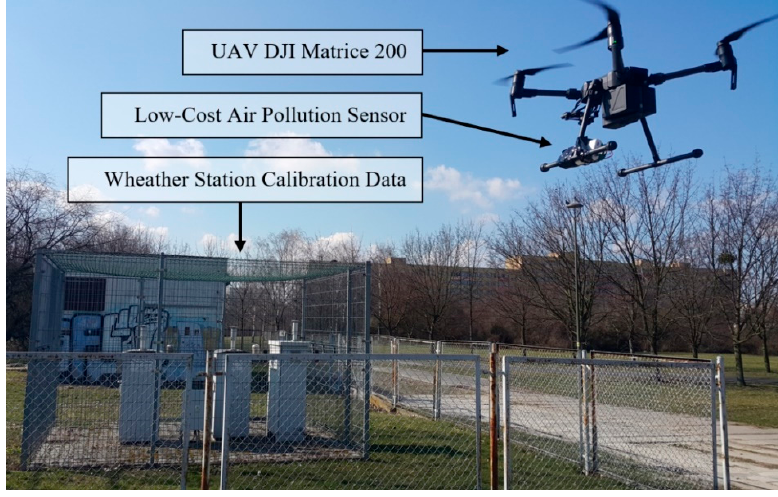
Figure 7. View of the mounted low-cost multi-sensor on the UAV during operation in location 2 (see Figure 1). Figure